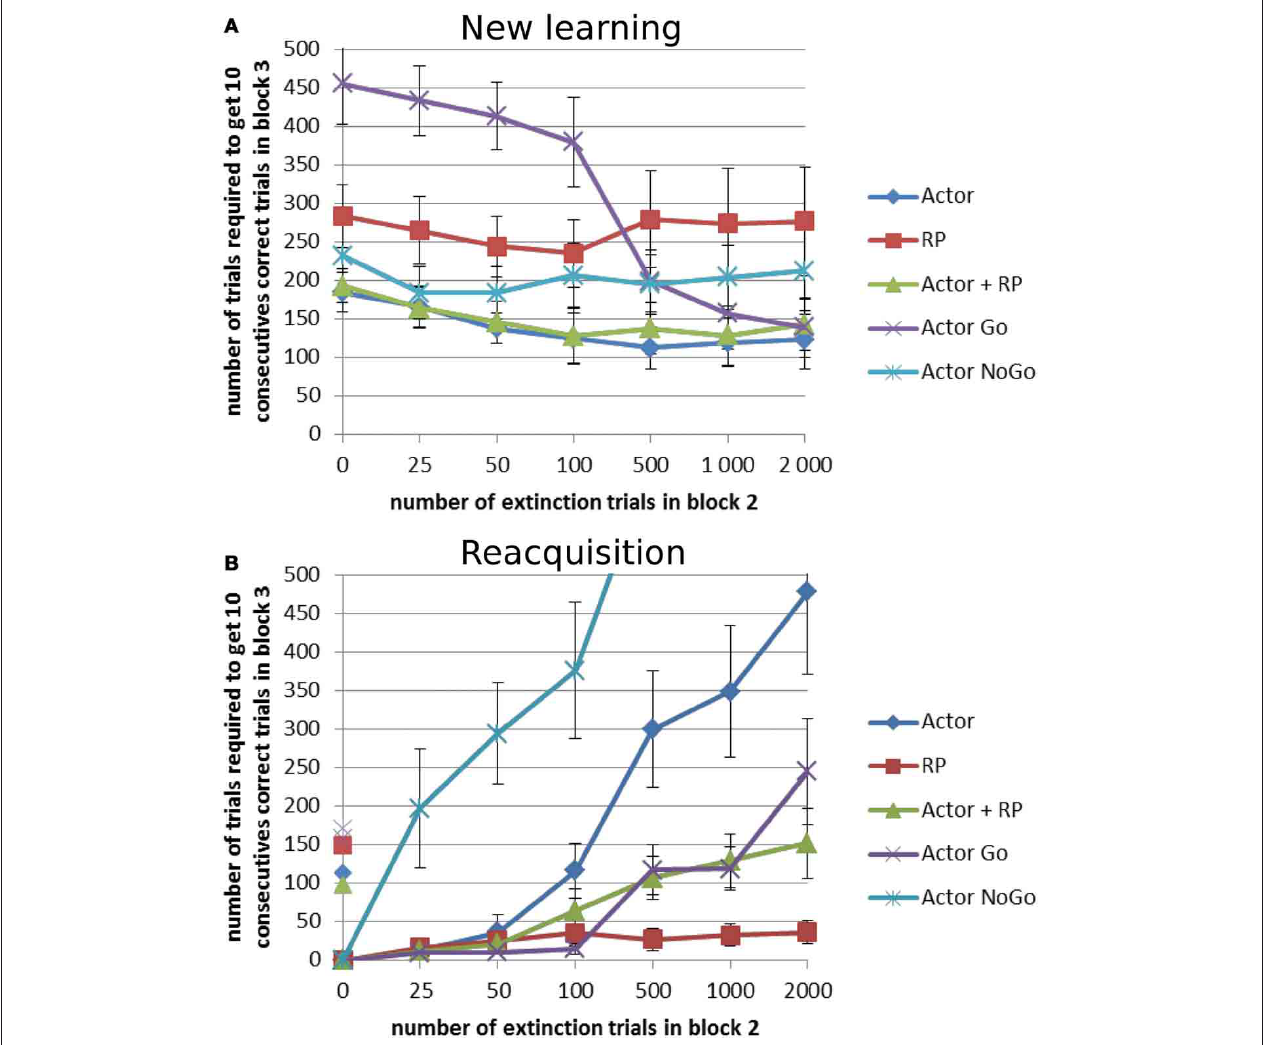
FIGURE 7 | Extinction–Reacquisition performance. Extinction between two learning blocks results in different performances in the second block depending on the task and on the selection mechanism. During blocks 1 and 3, reward probability was 100% and it was 0% during block 2. This block could count different number of trials: 0, 25, 50, 100, 500, 1000, or